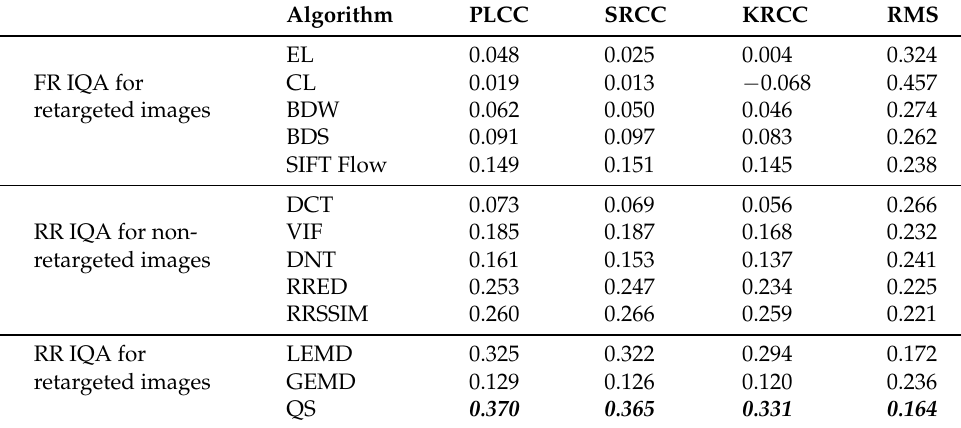
Table 2. The performance comparison with different IQA